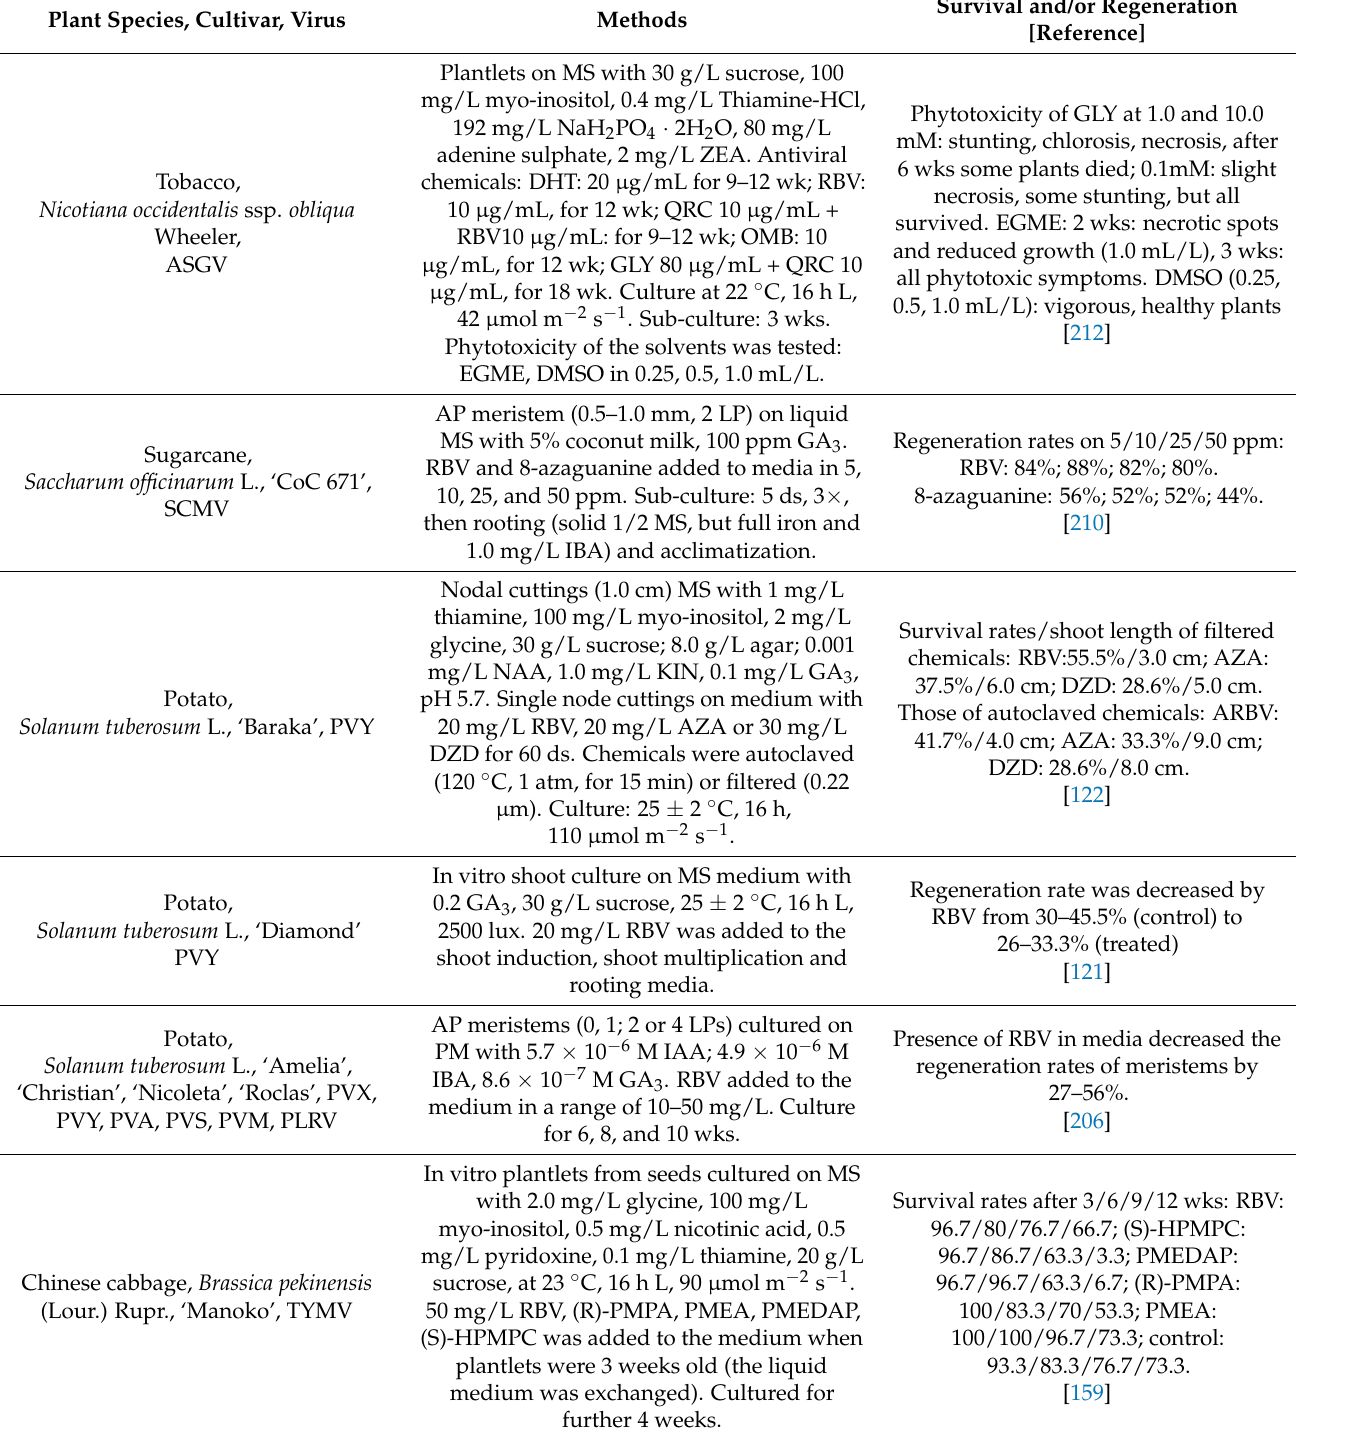
Table 5. Phytotoxic effect of the chemotherapy on herbaceous